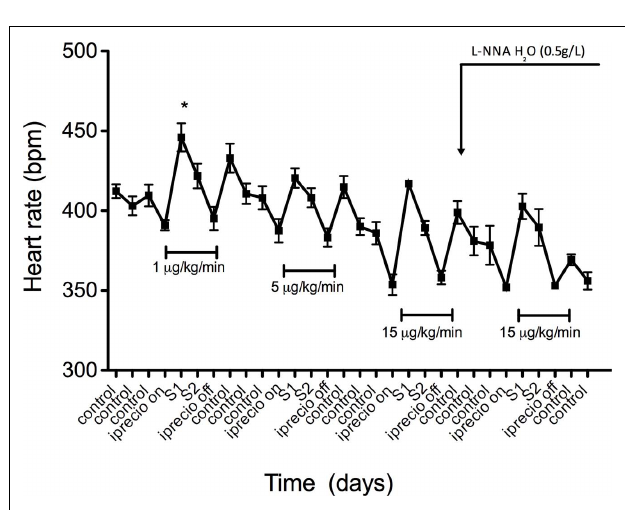
FIGURE 7 | Effects of increasing doses of 5-HT on mean heart rate (HR) in male Sprague Dawley. Points represent mean ± SEM for five (5) animals. Time is represented by days on the x -axis. S represents days of 5-HT infusion. *Statistically significant ( p < 0.05) difference from control heart rate. Horizontal bracketed bars indicate the time window over which 5-HT infusion was on.